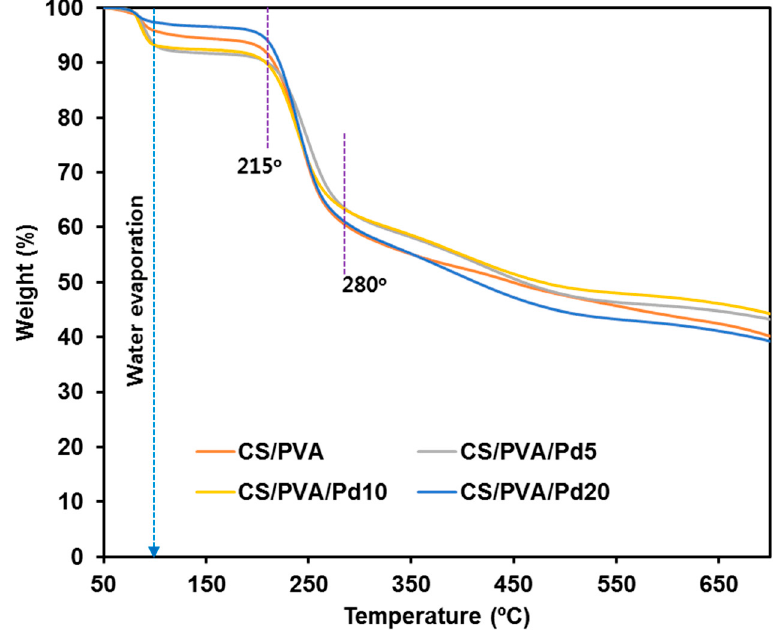
Figure 5. Thermogravimetric analysis (TGA) of CS/PVA and CS/PVA/PdNPs dressings.